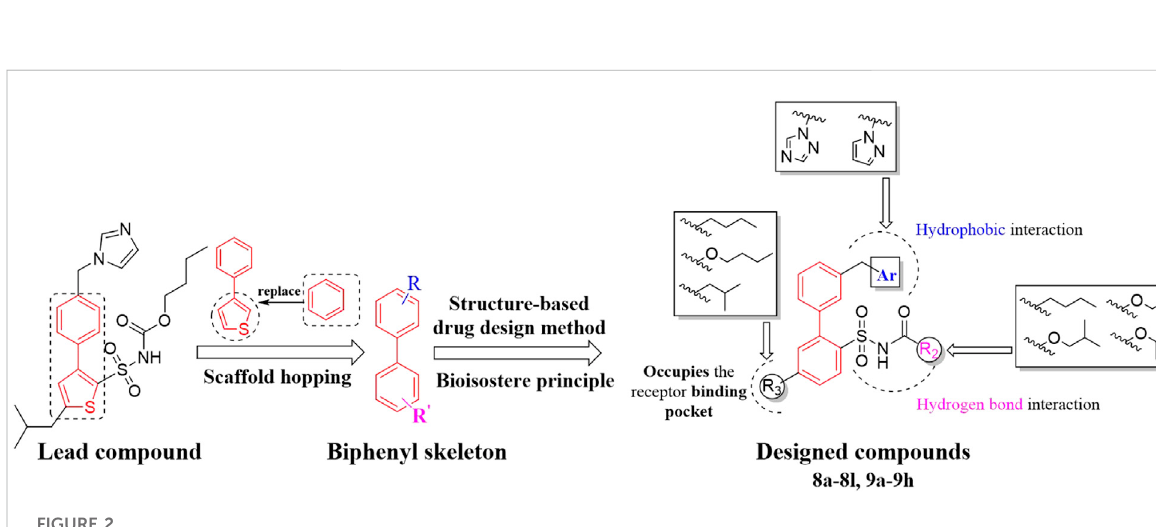
FIGURE 2 The design of target